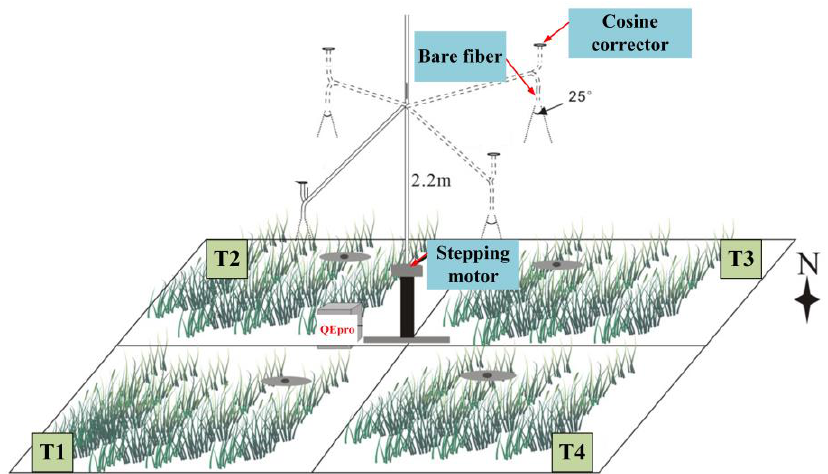
Figure 5. The automatic spectral monitoring system. The system consists of QEpro spectrometer, electronic switch, optical fiber, cosine corrector and so on. T1, T2, T3 and T4 represent well-watered, mild water stress, moderate water stress and severe water stress, respectively.